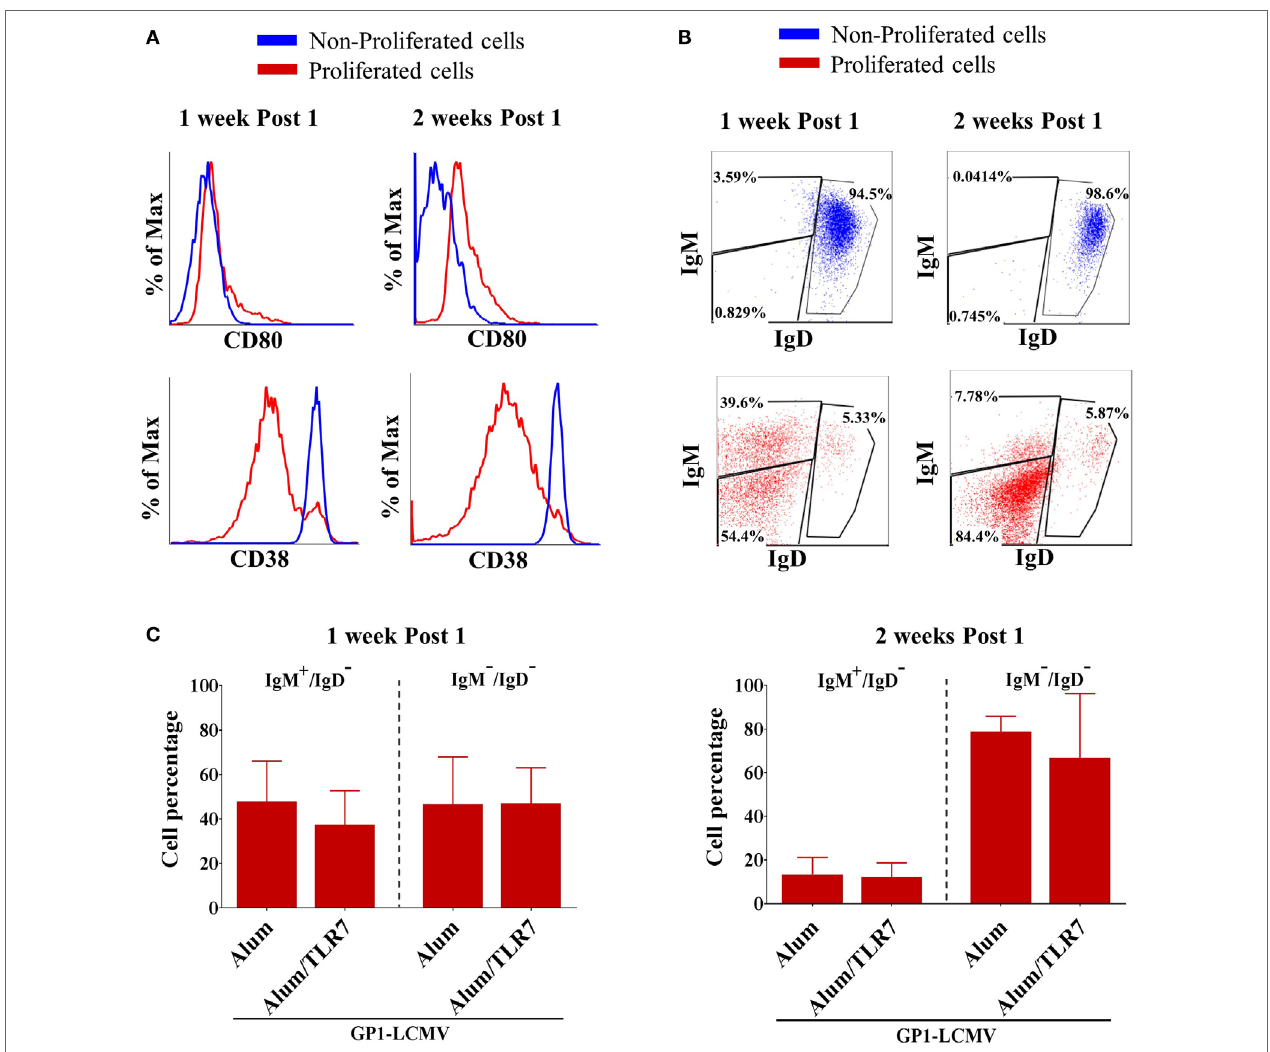
FigUre 2 | Phenotype of proliferated versus non-proliferated antigen-specific B cells. (a) Representative flow cytometry histograms for CD80 (upper panels) and CD38 (lower panels) expression in proliferated (red lines) versus non-proliferated (blue lines) antigen-specific B cells, 1 week and 2 weeks after the immunization. (B) Representative flow cytometry dot plots of IgM versus IgD expression by non-proliferated (upper panels, blue dot plots) versus proliferated (lower panels, red dot plots) antigen-specific B cells, 1 week and 2 weeks after the immunization. ( c) Percentage of IgM + /IgD − cells and IgM − /IgD − cells within proliferated antigen-specific B cells 1 week and 2 weeks after immunization with glycoprotein 1 of lymphocytic choriomeningitis virus (GP1-LCMV) adjuvanted with Alum or Alum/toll-like receptor 7. Bar graphs plot the average results, with SD, of five independent